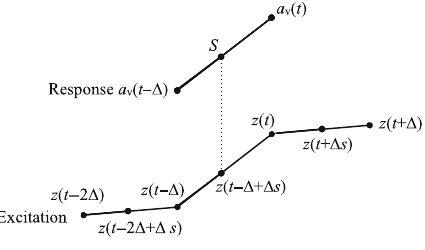
Fig. 5 Split point of the responses and